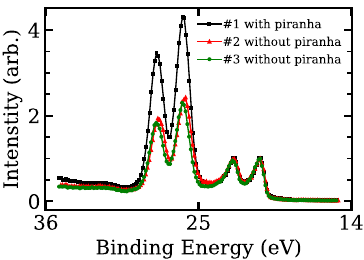
Fig. 2 The XPS spectra of three Ta samples. Two peaks at low binding energy belong to 4f 7/2 and 4f 5/2 orbitals of tantalum metal, and two peaks at higher energy correspond to the same orbitals of Ta 2 O 5 . The black line indicates that the sample has been dipped into piranha solution for 20 min with a temperature over 70 °C, and shows thicker tantalum oxide than others that are not dipped into piranha solution.